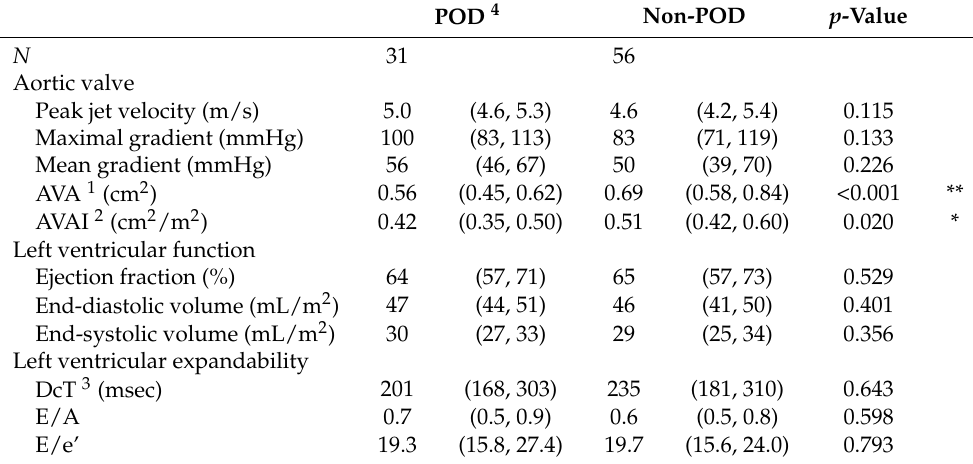
The risk factors for POD are shown separately. Values are expressed as medians (interquartile ranges). The Wilcoxon test was used to compare the data between POD and non-POD patients. * p < 0.05, ** p < 0.01. 1 AVA,